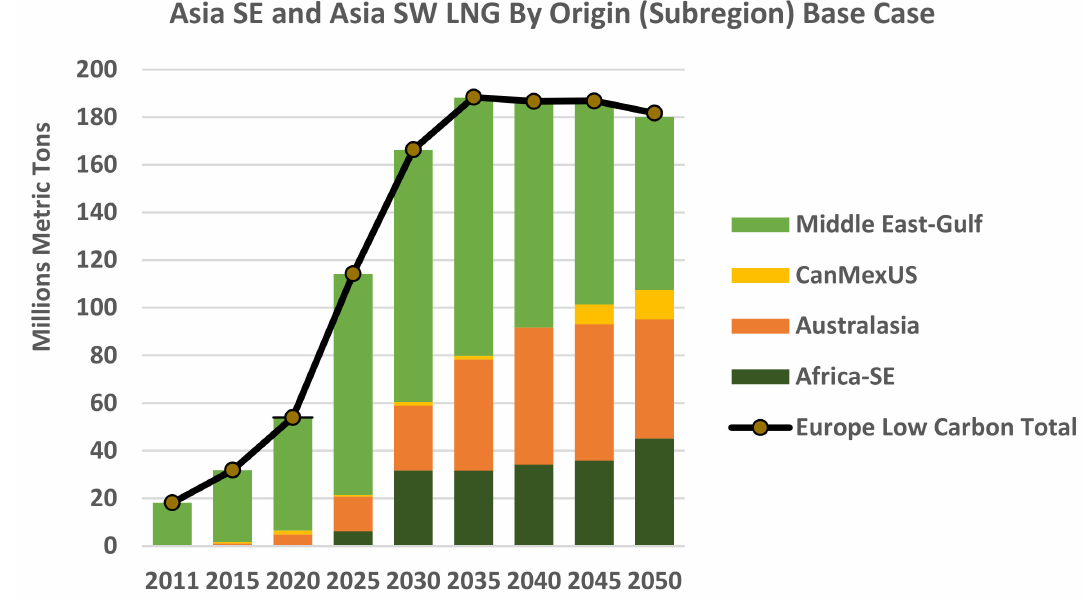
Figure 26. SE and SW Asia total LNG by origin in base vs. low-carbon